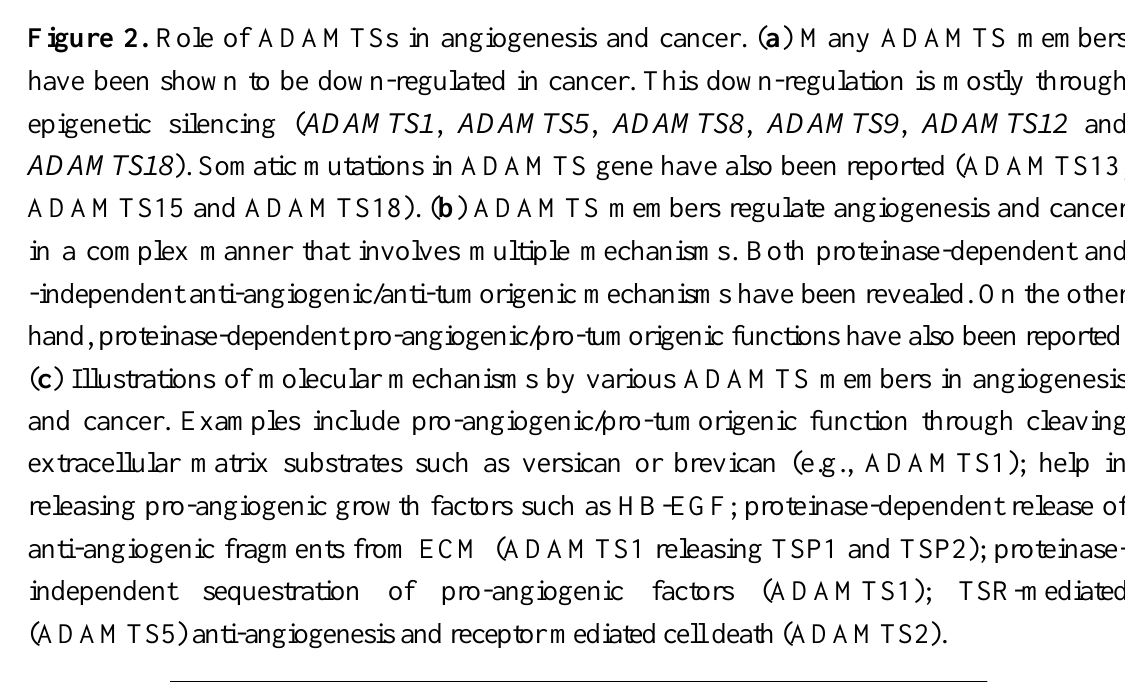
Figure 2. Role of ADAMTSs in angiogenesis and cancer. ( a ) Many ADAMTS members have been shown to be down-regulated in cancer. This down-regulation is mostly through epigenetic silencing ( ADAMTS1 , ADAMTS5 , ADAMTS8 , ADAMTS9 , ADAMTS12 and ADAMTS18 ). Somatic mutations in ADAMTS gene have also been reported (ADAMTS13,